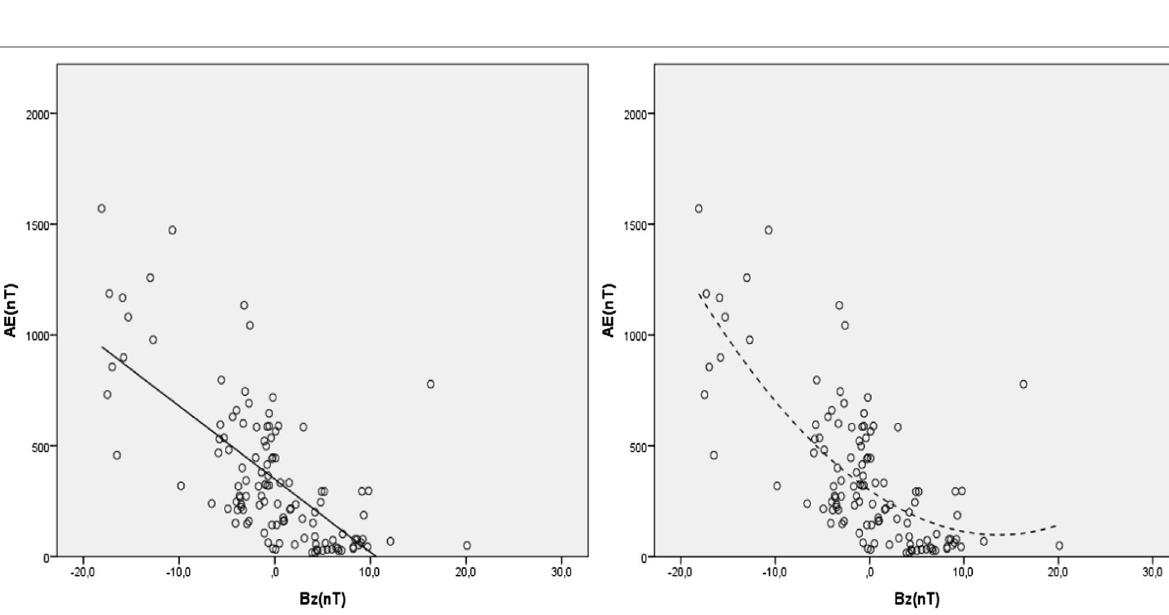
Fig. 5 Linear and quadratic relation of AE and B z . In figure, the nonlinear relationship between the magnetic field component B z and the AE index can be